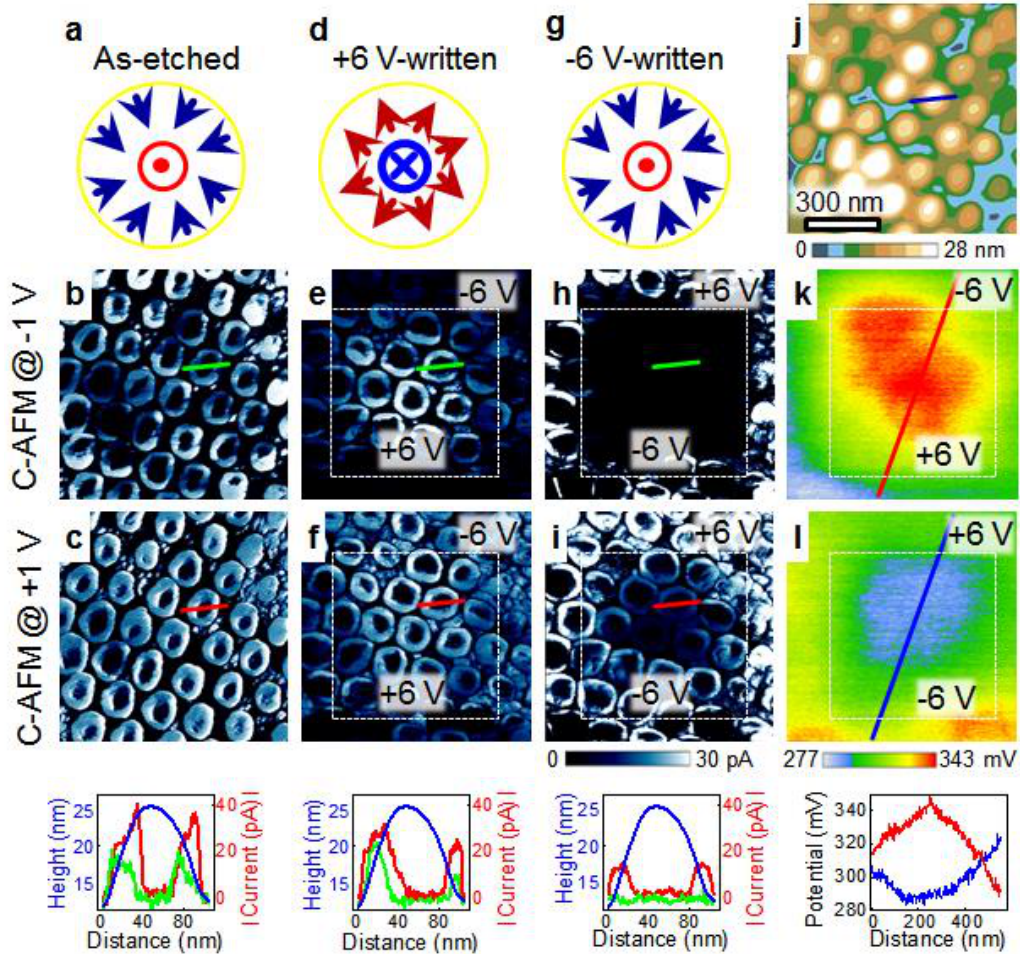
Figure 2. Domain structures, current maps and surface potential images before and after electrical writing. ( a , d , g ) Domain structures, and current maps scanned with ( b , e , h ) − 1 V and ( c , f , i ) +1 V for the BFO nanodots: ( a , b , c ) in the as-etched state, ( d , e , f ) after writing with − 6 V (outer)/+6 V (inner), and ( g , h , i ) after writing with +6 V (outer)/ − 6 V (inner). ( j ) Topography image of the BFO nanodots. Surface potential images taken after writing with ( k ) − 6 V (outer)/+6 V (inner) and ( l ) +6 V (outer)/−6 V (inner). Insets at the bottom show the height, current and surface potential profiles along the section lines.